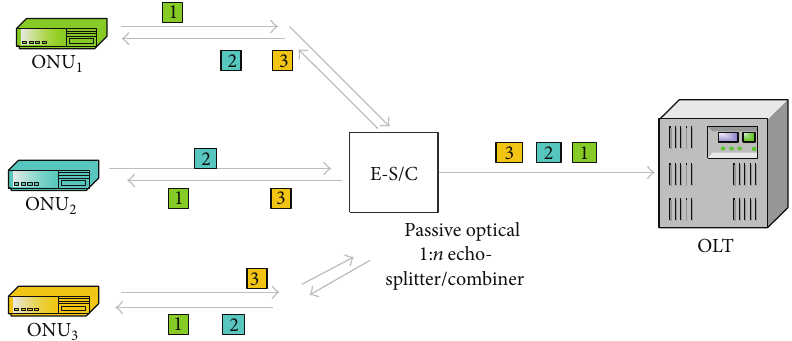
Figure 4: Load notification of ONUs via signaling channel by means of the echo splitter.